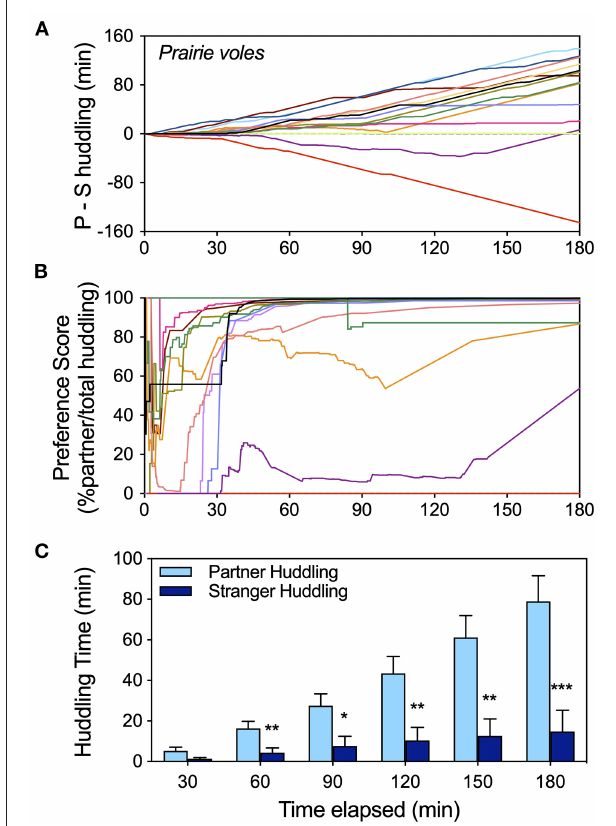
FIGURE 2 | Timeline analysis of the development of huddling preferences in a cohort of female prairie voles using three metrics of preference (data extracted from raw scoring files for all tests labeled “pvole-2” in the Supplementary Data ). (A) Cumulative display of huddling preferences (partner-stranger huddling) illustrates the trajectory of preference over the course of the test, as well as heterogeneity of behavior. (B) The trajectory of preference score stabilizes sooner, and by 1hour is a good indicator of preference for most subjects. (C) Huddling times at half hour intervals illustrate how the full test interval is useful for a larger gap between partner and stranger contact to emerge. Statistical comparisons of partner vs. stranger huddling, as well as differences from expected values for preference metrics (0 for P-S huddling; 50% for preference score) at half hour intervals appear in Supplementary Table 3 . * = p < 0.05, ** = p < 0.01, *** = p <